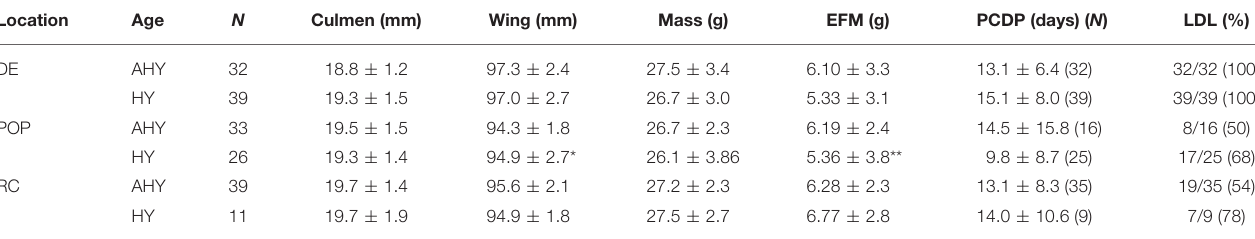
TABLE 1 | Summary (mean ± standard deviation) of morphometric and detection data from Semipalmated Sandpipers tagged at three locations in the Gulf of Maine (DE, Downeast 2013–14; POP, Popham Beach 2015–16; RC, Rachel Carson NWR 2014–15; years pooled for each location). Location